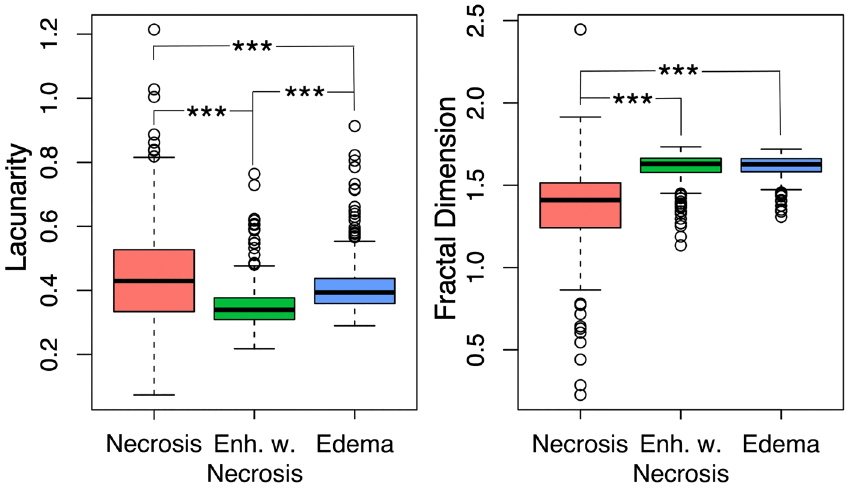
Figure 6. Significant differences in lacunarity and fractal dimension between regions of interest. (Left) We note significant differences in lacunarity values across all three regions of interest, with necrosis the highest, followed by edema, followed by enhancement with necrosis (all comparisons p < 0.001). (Right) Fractal dimension values are significantly higher in edema and enhancement with necrosis when compared with necrosis (p < 0.001), but